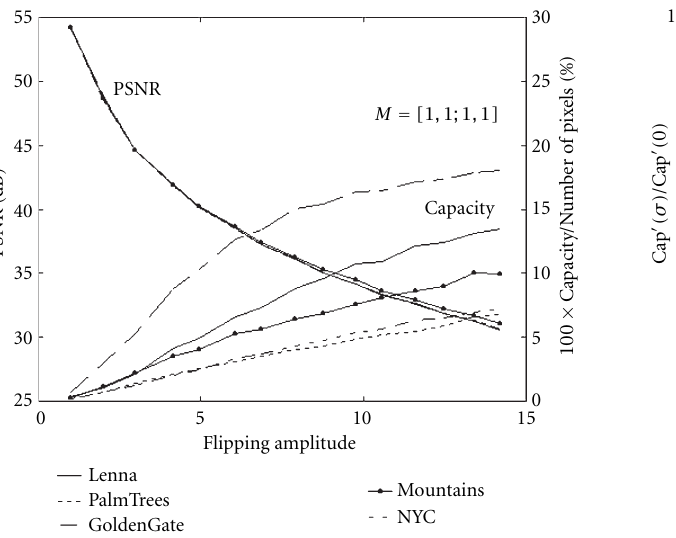
Figure 4: Capacity-amplitude-distortion.